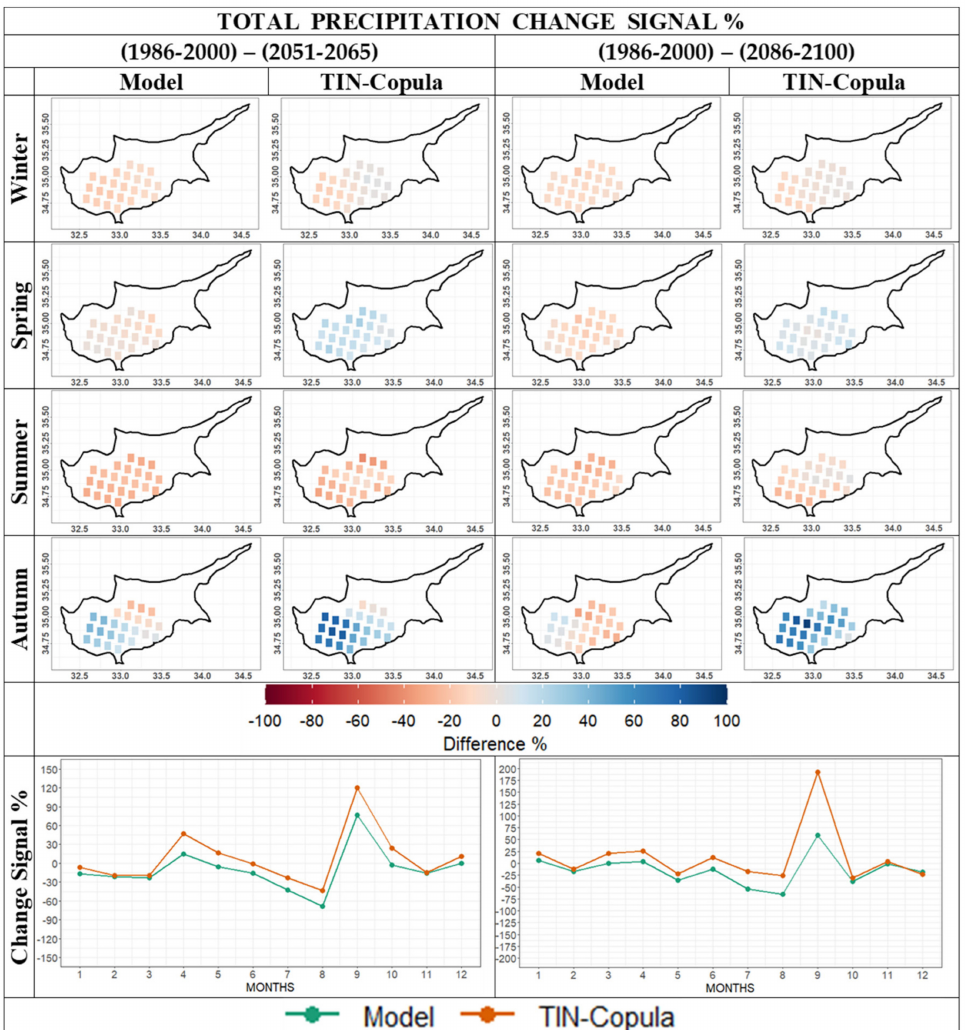
Figure 13. Climate change signal (CCS) of total precipitation, before and after the use of the TIN-Copula